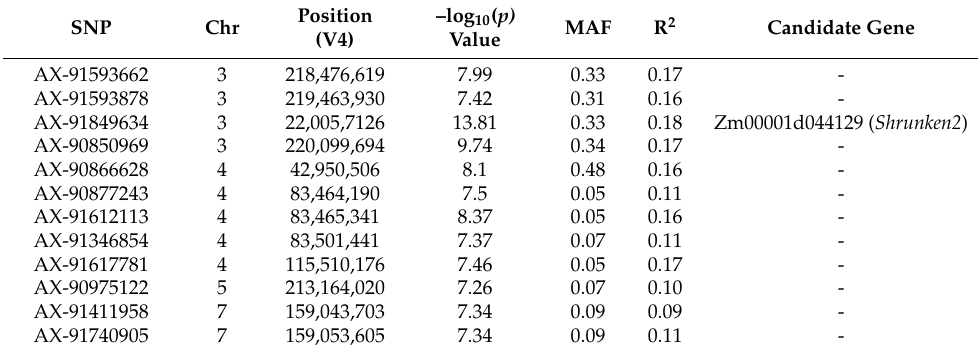
Figure 3. GWAS results for sweetness trait in 250 sweet- and waxy-corn inbred and recombinant inbred lines (RILs), genotyped with 159,201 SNPs, using a mixed linear model implemented in GAPIT. ( A ) Manhattan plots. Each dot represents a SNP. Bonferroni threshold of –log 10 p -value = 13.81 is presented by a green line on Manhattan plots. Most associated SNP AX_91849634, located 67.5 kb on chromosome 3 near the Shrunken2 gene, is indicated by a red arrow. ( B ) Quantile–quantile (Q–Q) plots. The plot shows the expected vs. observed –log 10 ( p ) of each marker (blue dots). Red line is a guide for the perfect fit to expected –log 10 ( p ). The gray shaded area shows the 95% confidence interval for the Q-Q plot under the null hypothesis of no association between the SNP and the trait. Table 1. List of significantly associated SNPs identified by GWAS showing SNP IDs, chromosomes, positions, –log 10 ( p ) values, minor-allele-frequency (MAF) values, marker R 2 values, and candidate